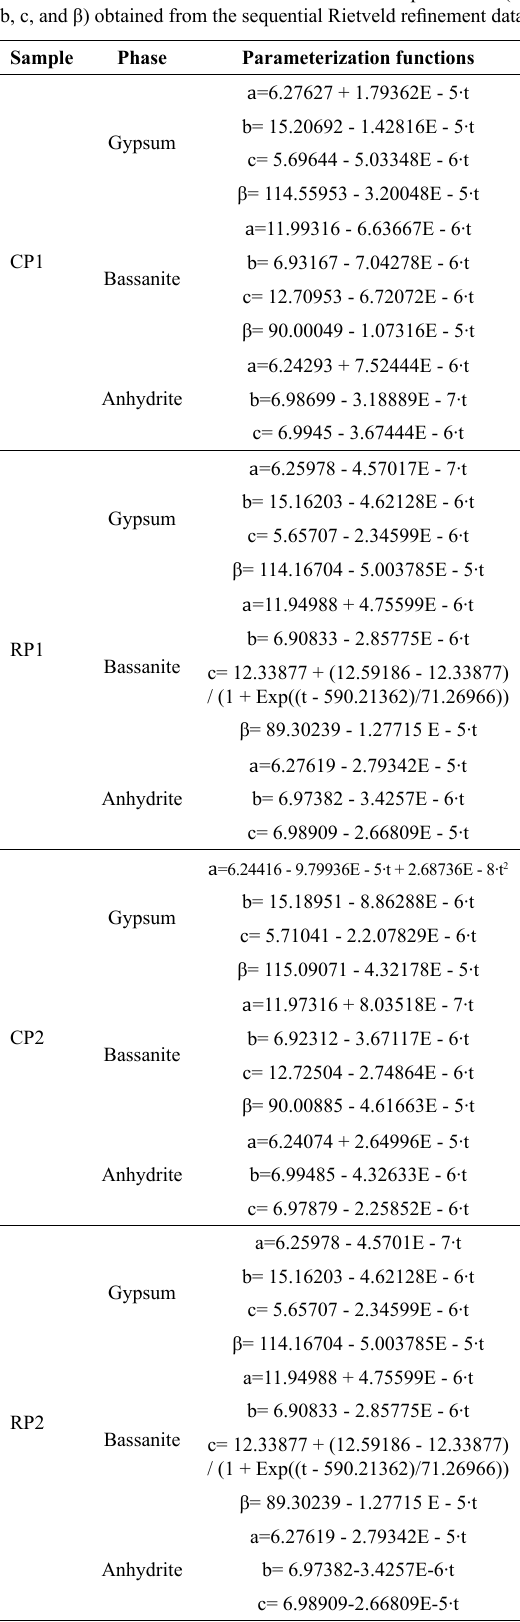
Table 8. Parameterization functions of the unit cell parameters (a, b, c, and β) obtained from the sequential Rietveld refinement data